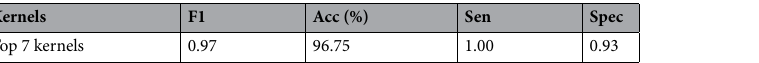
Table 8. Best MKL results obtained by combining the top 7 kernels applied to the validation (peptide) data.